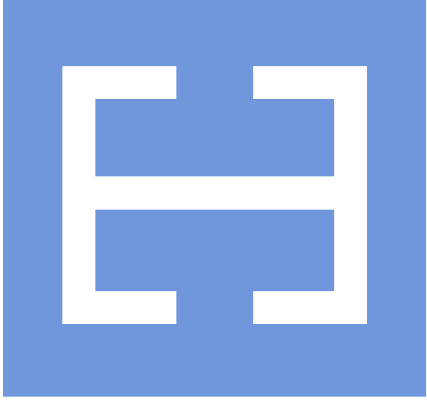
Figure 17. Two rotationally symmetric ‘E’